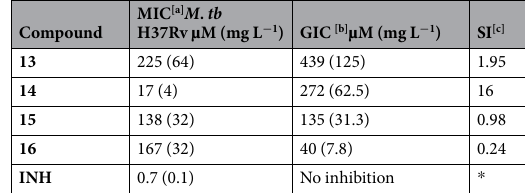
Table 2. Cytotoxicity profile of compounds 13 – 16 and selectivity against the murine macrophage cell line RAW 264.7 using the resazurin assay. INH was used as a control drug and shows no effect on the viability of the cells. A drop in the fluorescence levels indicate loss of viability of cells as determined by the reduction in the oxidation of resazurin to resorufin which in turn fluoresces. The experiments were performed in triplicate. where SI = GIC/MIC (SI calculated using the µ M values in Table 2). [d] INH- Isoniazid (control, front-line anti- tubercular drug) * . As no significant inhibition is observed the SI in these cases cannot be